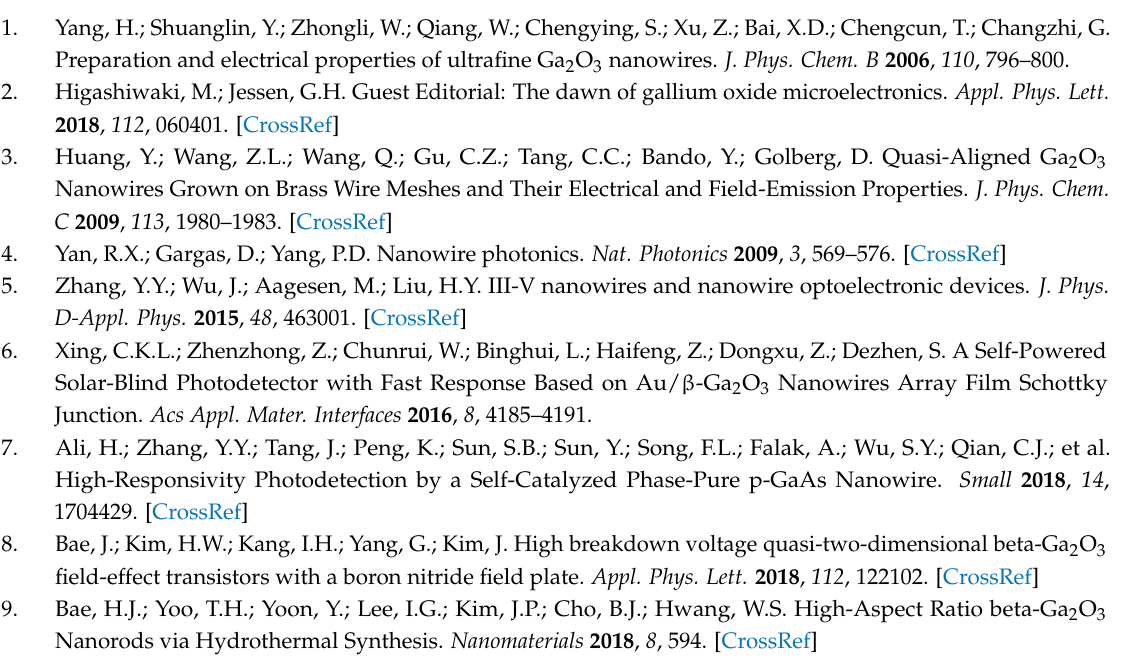
Figure S1: The broad views of several different sizes Cu 2 O cubes synthesized by chemical methods. Table S1: Synthesis conditions of Cu 2 O using ascorbic acid as a reductive agent. Table S2: Catalyst size, NW diameter, and corresponding standard deviation. Figure S2a–c: HRTEM of catalyst heads of different Ga 2 O 3 NWs and d is the TEM image and elemental atomic ratio of the